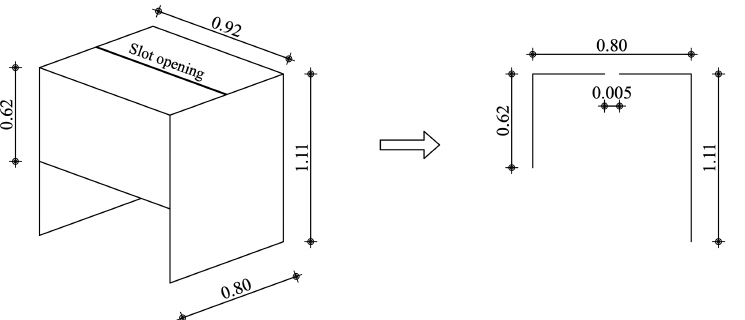
Figure 6. Dimensions of the physical model used in the experiments of Zabihi et al. [40] and of its cross-section (in m).